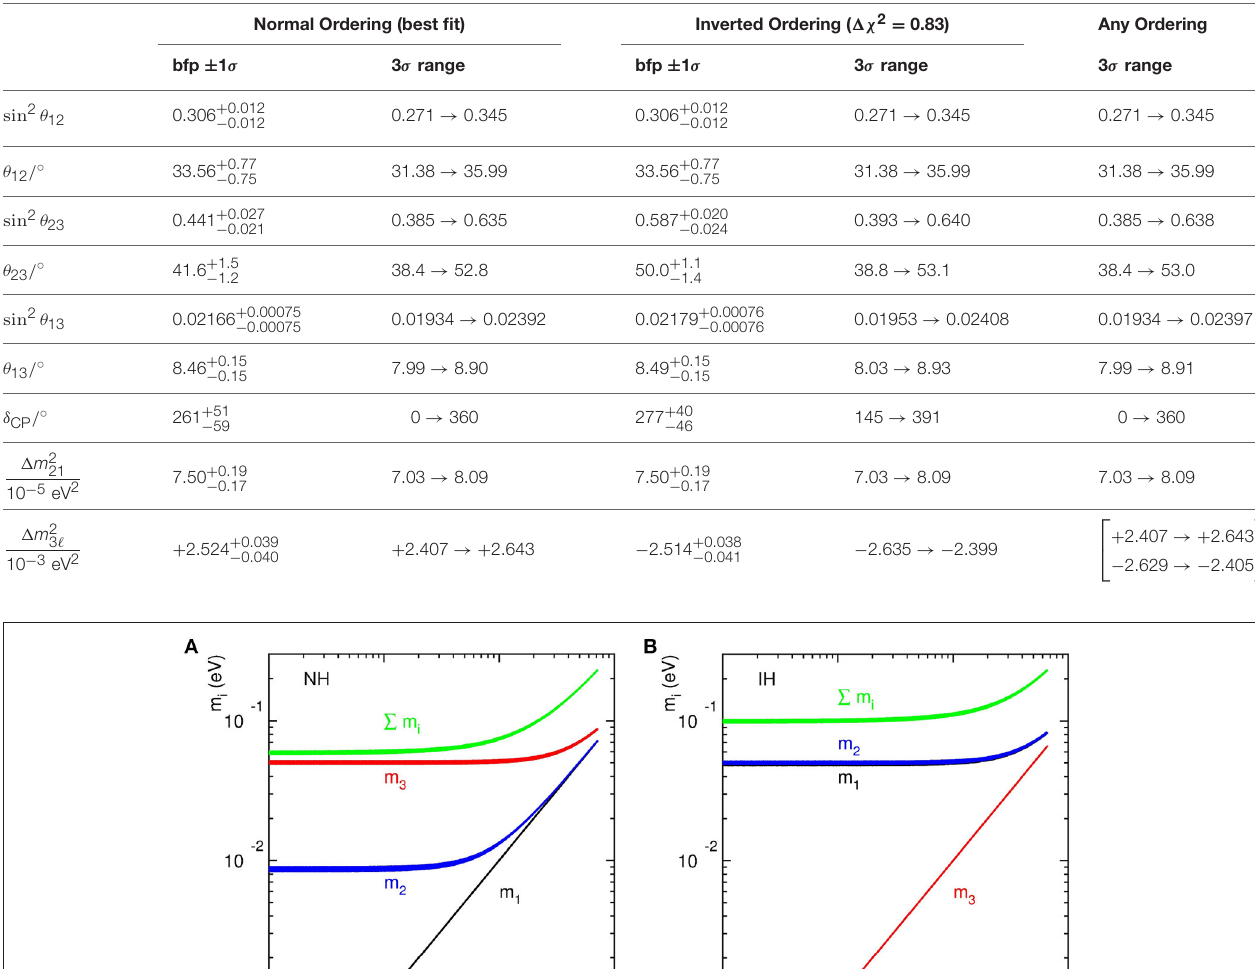
TABLE 1 | Three-neutrino oscillation fit based as obtained by the NuFit collaboration, taken from Esteban et al. [72], where 1 m 2 3 ℓ 1 m 2 32 < 0 for IO (or IH). 1 m 2 3 ℓ =